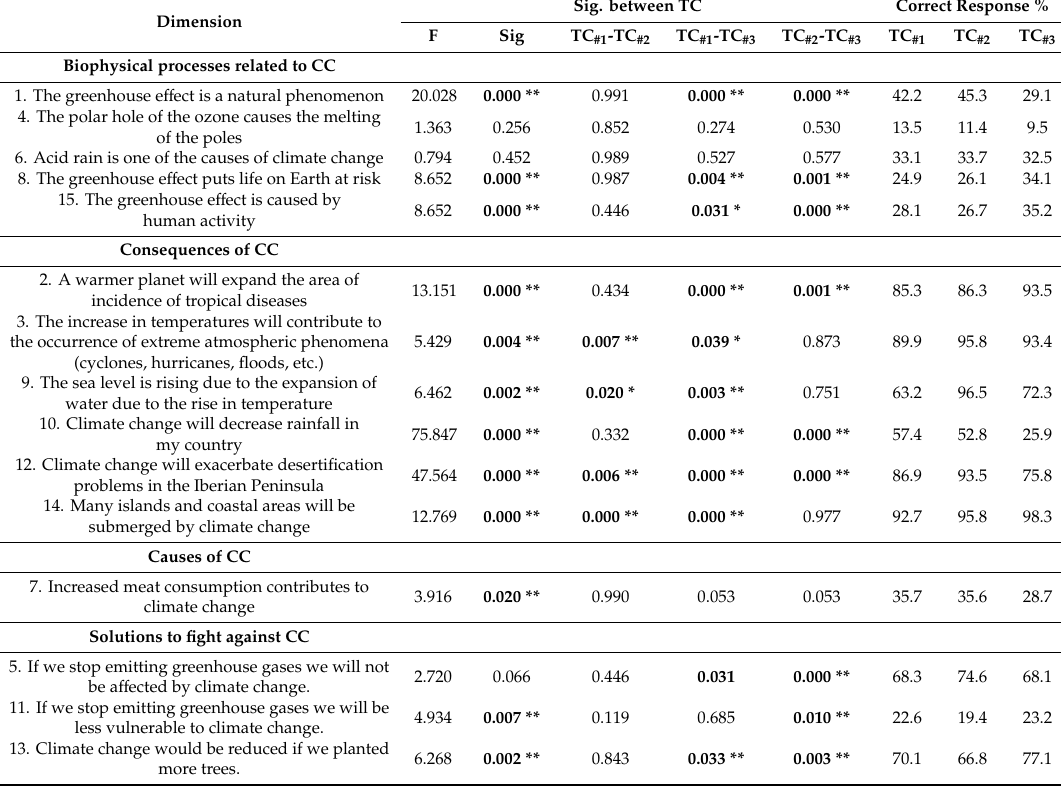
Figure 8. Degree of information about CC and pro-environmental attitudes. Table 9. Significant di ff erences by items of dimensions of CC and TC and correct response Table 8. Significant differences by items of dimensions of CC and TC.